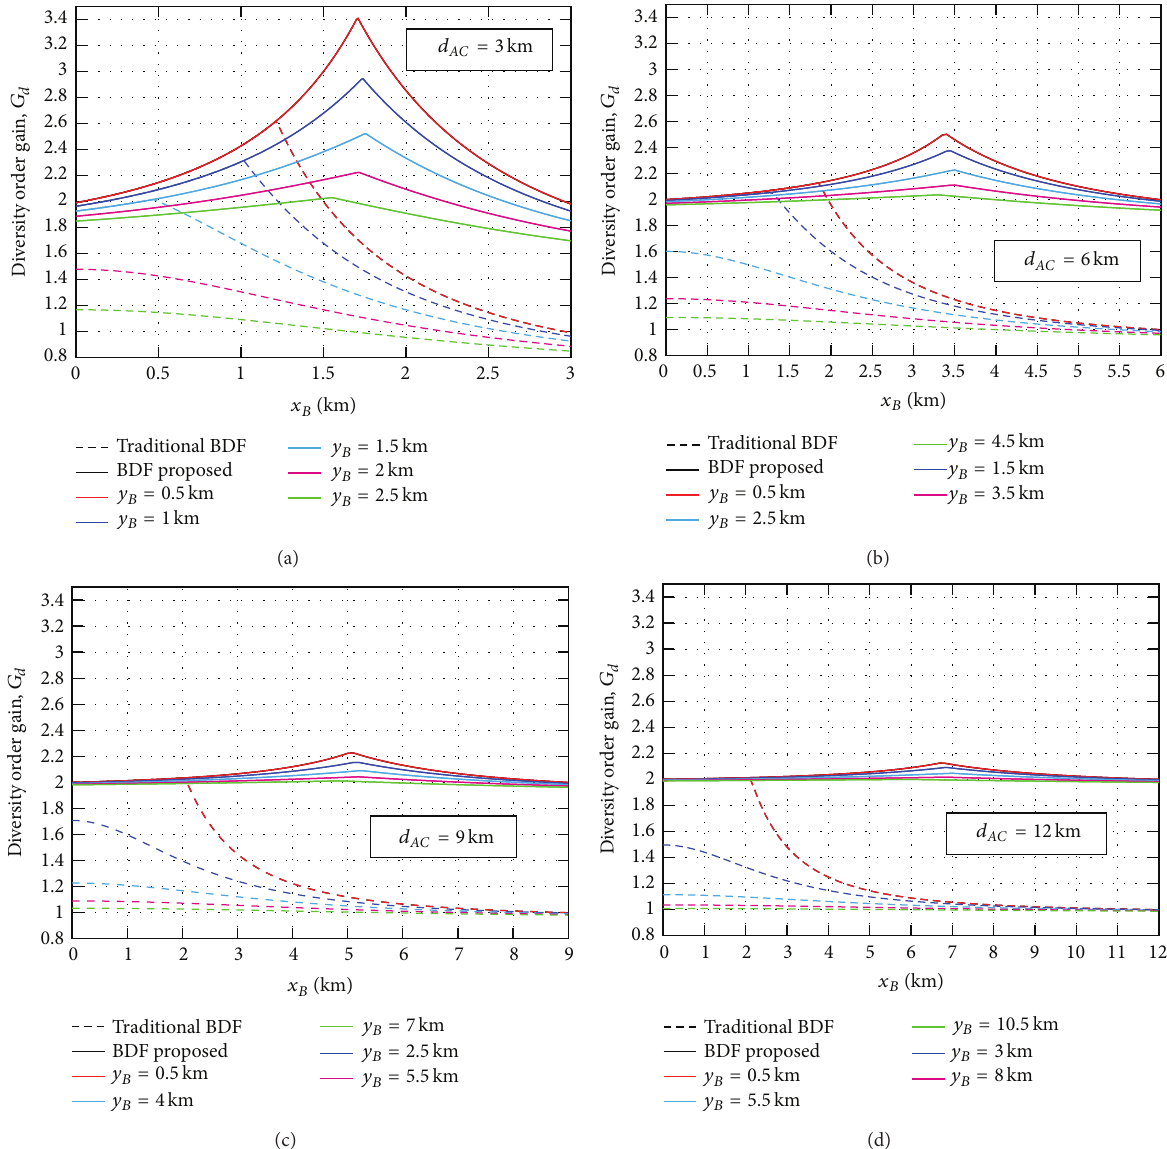
Figure 2: Diversity order gain for source-destination link distances of 𝑑 𝐴𝐶 = {3, 6,9, 12} km when different relay locations are assumed.